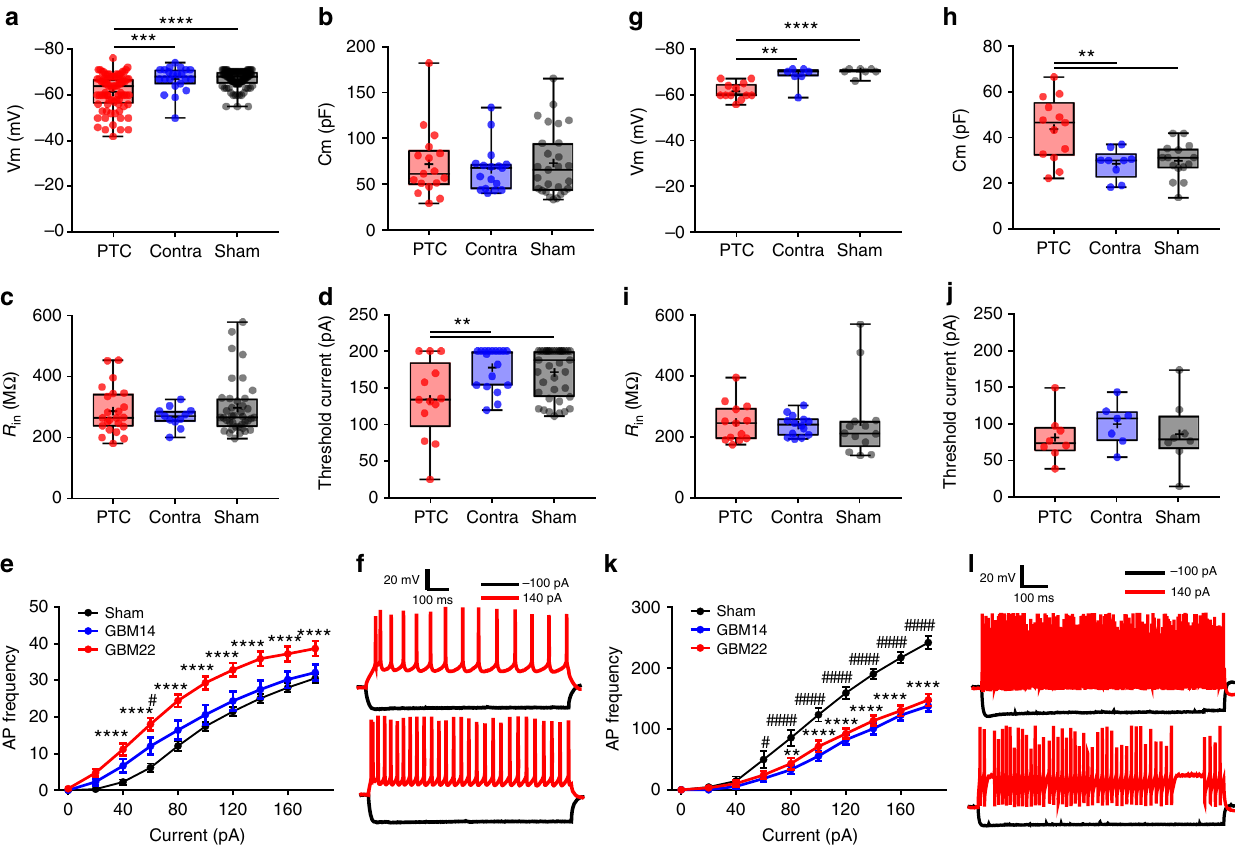
Fig. 6 Altered biophysical properties of excitatory and inhibitory neurons in the PTC. a Depolarized excitatory neurons in the PTC (61.49 ± 0.86, n = 80 (11)) than in contralateral (67 ± 1.16, n = 22(6)), and sham (67.02± 0.38, n = 98(15)). b Membrane capacitance (Cm) of excitatory neurons (PTC, 72.90 ± 8.92, n = 17(10); contralateral, 67.46 ± 6.11, n = 17(8); sham, 73.93 ± 6.95, n = 27(10)). c Input resistance ( R in ) of excitatory neuron in the PTC (PTC, 288.20 ± 15.82, n = 23(10); contralateral, 269.22 ± 10.35, n = 11(5); sham, 298.63 ± 14.47, n = 39(10)). d Threshold current of excitatory neurons in the PTC (134.76± 14.69, n = 13(8)); contralateral (177.55± 6.69, n = 18(8)); sham (171.33 ± 5.28, n = 39(10)). e Higher AP frequency of excitatory neurons in GBM22 PTC ( n = 27(10)) than GBM14 ( n = 12(7)), and sham ( n = 36(10)). f Representative traces of excitatory neuron ’ s fi ring from sham (upper) and GBM22 PTC (lower) on − 100pA (black) and 140pA (red) current steps. g Depolarized Vm of FSNs in GBM22 PTC (61.67 ± 1.01, n = 12(8)) compared to contralateral (68.14 ± 1.59, n = 7(6)) and sham (69.85 ± 0.67, n = 7(6)). h Higher Cm of FSNs in GBM22 PTC (43.84 ± 3.74, n = 13(8)) than in contralateral (28.82 ± 2.14, n = 9(8)) and sham (30.11 ± 1.99, n = 15(6)). i R in of FSNs in the PTC (249.10 ± 17.65, n = 13(9)), contralateral (240.08 ± 9.07, n = 14(7)), and sham (252.64 ± 35.30, n = 13(7)) was not different. j Threshold current of FSNs in the PTC (82.75 ± 11.49, n = 8(6)), contralateral (100.57 ± 10.94, n = 7(5)) and sham (87.25 ± 16.06, n = 8(5)) was not different. k AP (Spike) frequency of FSNs in GBM22 PTC ( n = 18(11)) and GBM14 PTC ( n = 19(7)) was signi fi cantly lower than in sham ( n = 10(7)). l Representative traces of FSN ’ s response from sham (upper) and GBM22 PTC (lower) on − 100pA (black) and 140pA (red) current steps. n = cells(mice) in all. The units for membrane potential (Vm), threshold current, membrane capacitance (Cm) and input resistance ( R in ) are mV, pA, pF, and M Ω , respectively. **** P < 0.0001, *** P < 0.001, ** P < 0.01, one-way ANOVA in ( a − d , g − j ); two-way ANOVA in ( e ) (sham vs. GBM22) and ( k ) (GBM22 vs. sham); Tukey ’ s post-hoc test in all. #### P < 0.0001, # P < 0.05, two-way ANOVA, Tukey ’ s post-hoc test in ( e ) (GBM14 vs. sham) and ( k ) (GBM14 vs.